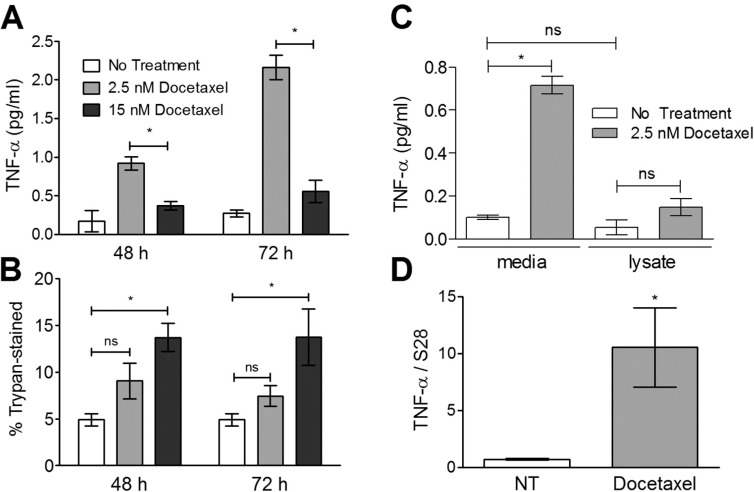
TNF-α release does not correlate with loss of membrane integrity.Cells were treated for 48 or 72 hours with one of two concentrations of docetaxel and the level of TNF-α in the media was measured (A) as well as the number of trypan-positive cells (B). The significance of differences in TNF-α levels or loss of membrane integrity were assessed using a 2-way ANOVA with a Tukey post-test. Cells were also lysed under hypotonic conditions and media levels of TNF-α from lysed and non-lysed were measured using an ELISA (C). TNF-α mRNA levels were also determined by quantitative PCR using cDNA generated from RNA extracts after 36 hours of docetaxel treatment. In these studies the significance of differences in TNF-α transcript levels between preparations was measured using an unpaired, two-tailed T-test; * p<0.05. All data represent the mean of three replicates (+/-SEM).